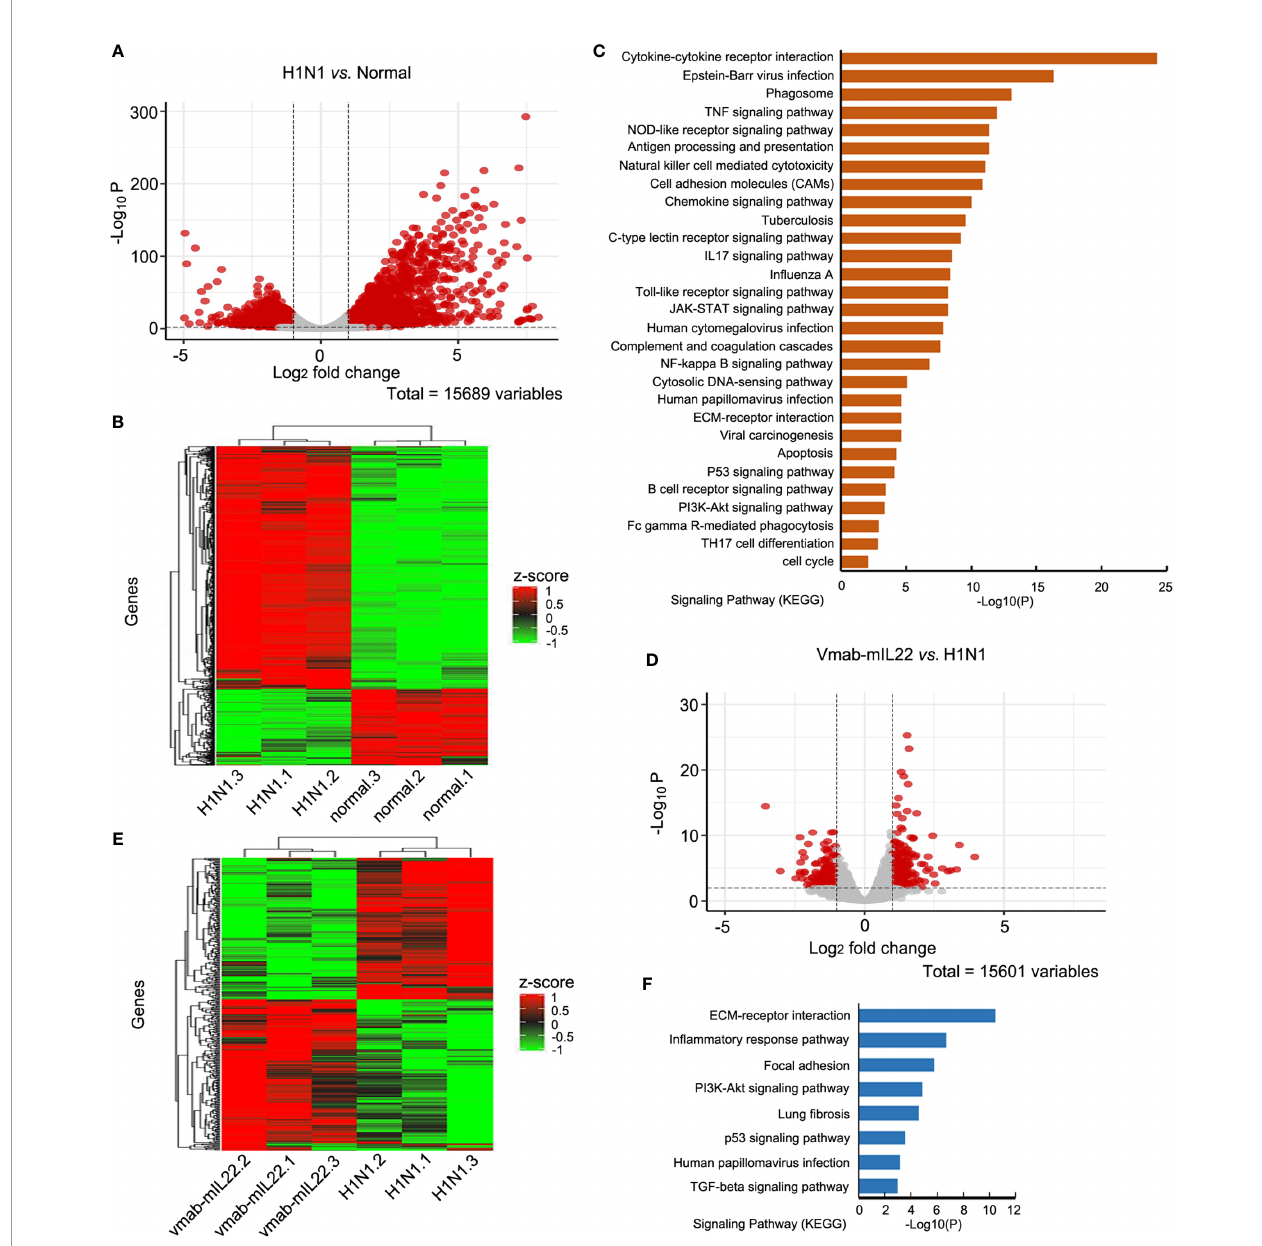
FIGURE 6 | Transcriptomics changes of H1N1 infection and vmab-mIL22 treatment. (A, B) The differential expressed gene (DEG) analysis results were shown in volcano plots and differential expressed (DE) genes (|log2-fold change| >=1.0 and BH-adjusted P <= 0.05) between H1N1-infected and normal mice were selected for cluster analysis in heatmap. Among the DE genes, a set of 1823 genes showed upregulated expression, and the remaining 1340 genes showed downregulated expression. Each row represents an individual gene, and each column represents an individual sample. (C) Pathway analysis of genes found to be signi fi cantly upregulated in H1N1- infected mice. The top 29 signi fi cantly affected signaling pathways are shown. (D, E) The DE genes between vmab-mIL22-treated and H1N1-infected mice were selected for cluster analysis in heatmap. Among the DE genes, a set of 349 genes were upregulated, and the remaining 253 genes were downregulated. (F) Pathway analysis of genes found to be signi fi cantly downregulated in vmab-mIL22-treated mice. Eight signi fi cantly affected signaling pathway is